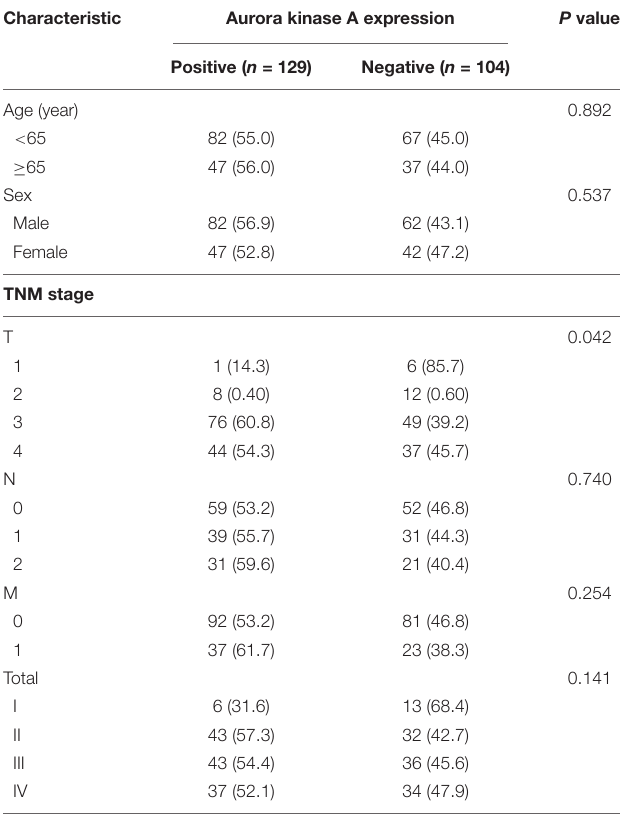
TABLE 1 | The relationships between Aurora A expression and clinicopathological characteristics. Characteristic Aurora kinase A